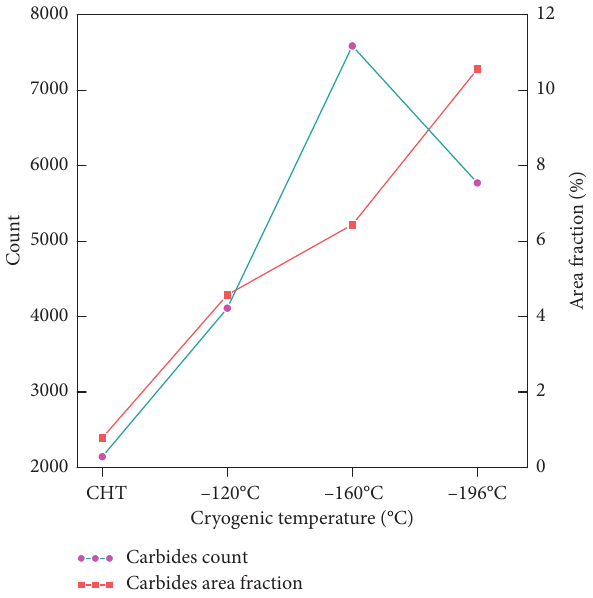
Figure 12: The number of precipitated carbides of CHT and CTs with different cryogenic temperatures. Figure